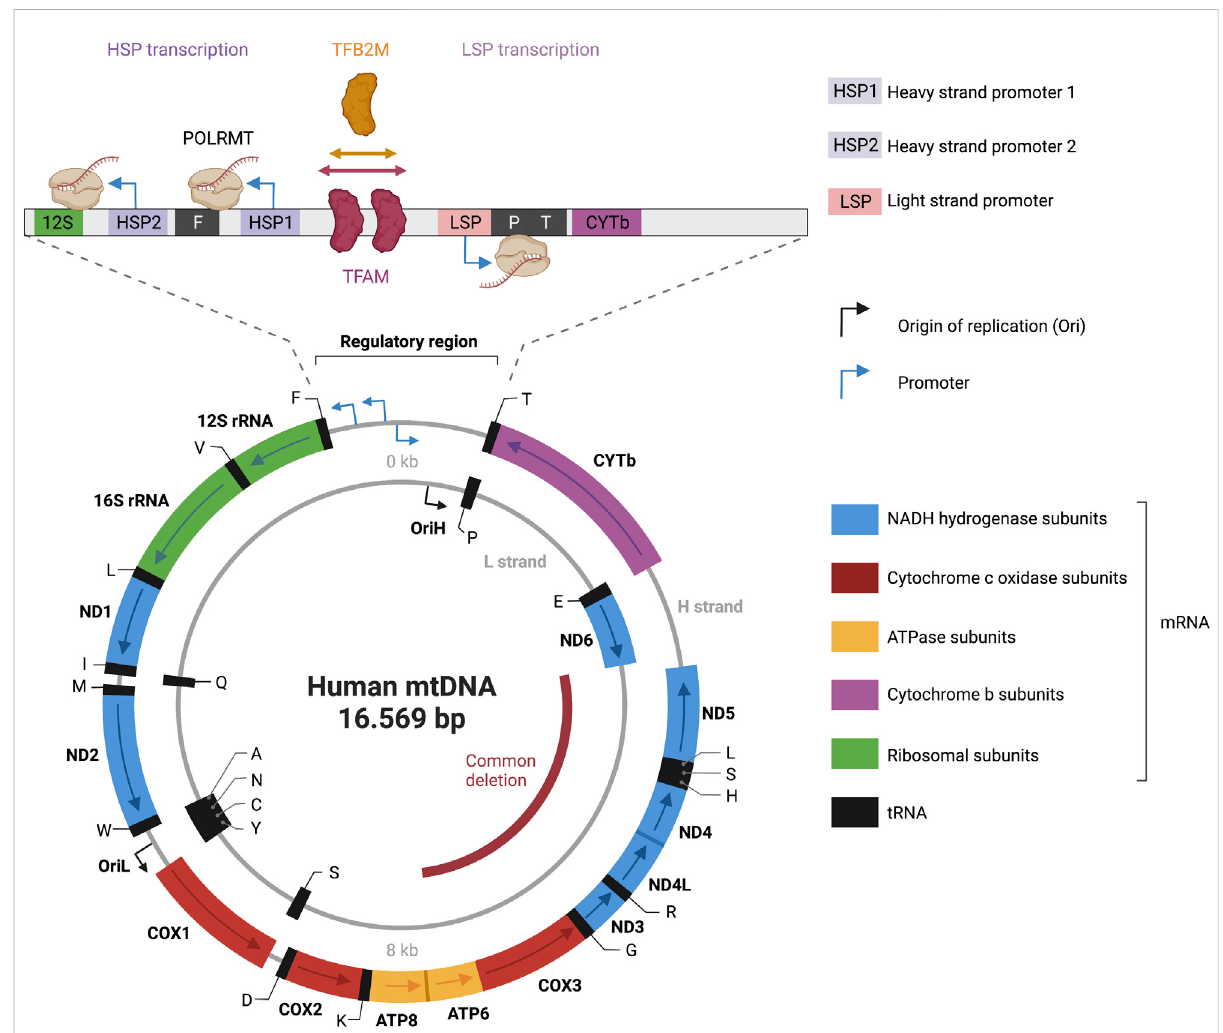
FIGURE 3 Representation of the human mitochondrial DNA transcription. Depicted is a map of the 16.569 bp circular, double-stranded mitochondrial genome. The heavy strand is depicted as outer circle and the light strand as inner circle. mRNA genes coding for NADH hydrogenase subunits are labeled in blue; mRNA genes coding for Cytochrome c oxidase subunits are labeled in red; mRNA genes coding for ATPase subunits are labeled in yellow; mRNA genes coding for cytochrome b subunits are labelled in purple; rRNA genes are labelled in green; tRNAs genes are labelled in black. Transcriptional directionality is speci fi ed for mRNAs and rRNAs. The displacement loop (D-loop) noncoding control region is depicted as expanded). D-loop encompasses three promoters: heavy-strand promoter 1 and 2 (HSP1, HSP2), and light-strand promoter (LSP). Transcription of the heavy strand initiated from HSP1 generates a short transcript terminating at the 16S rRNA. Transcription of the heavy strand initiated from HSP2, generates a polycistronic mRNA including 12 mRNA genes, 2 rRNAs and 14 tRNA genes. Light-strand transcription from the light-strand promoter (LSP) generates ND6 mRNA and 8 tRNAs. The transcription start site (TSS) of LSP, HSP1 and HSP2 has been established to be located position 407/ 408, 561, 643/644 respectively (Montoya et al., 1983; Chang and Clayton, 1984; Zollo et al., 2012). A comparison of the three promoter sequences revealed a mild consensus in the base pairs around the TSS with the -7A,-3C,+1 to +3AAA, and +5A being conserved positions in all three promoters (Basu et al., 2020). The transcription activator TFAM (transcription factor A, mitochondrial) and dimethyladenosine transferase 2, mitochondrial (TFB2M) are required to bind mtDNA upstream of all three promoters, recruiting a single subunit RNA polymerase (POLRMT). The fi gure has been generated using Biorender.